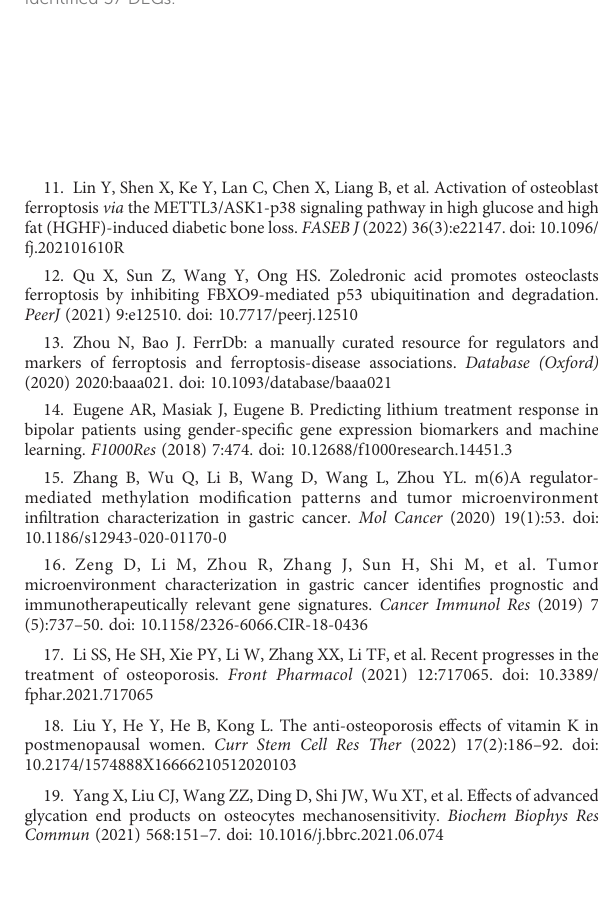
SUPPLEMENTARY TABLE 2 Acquired 45DEFAGs. SUPPLEMENTARY TABLE 3 Identi fi ed 37